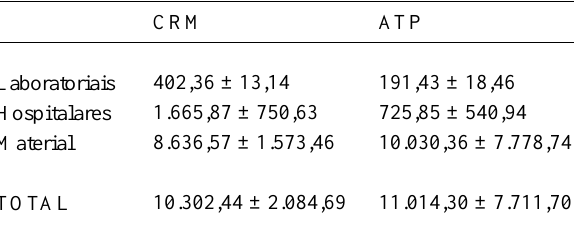
Tabela 2. Custos (R$), por procedimento, de internamento e ao final do 1º ano.